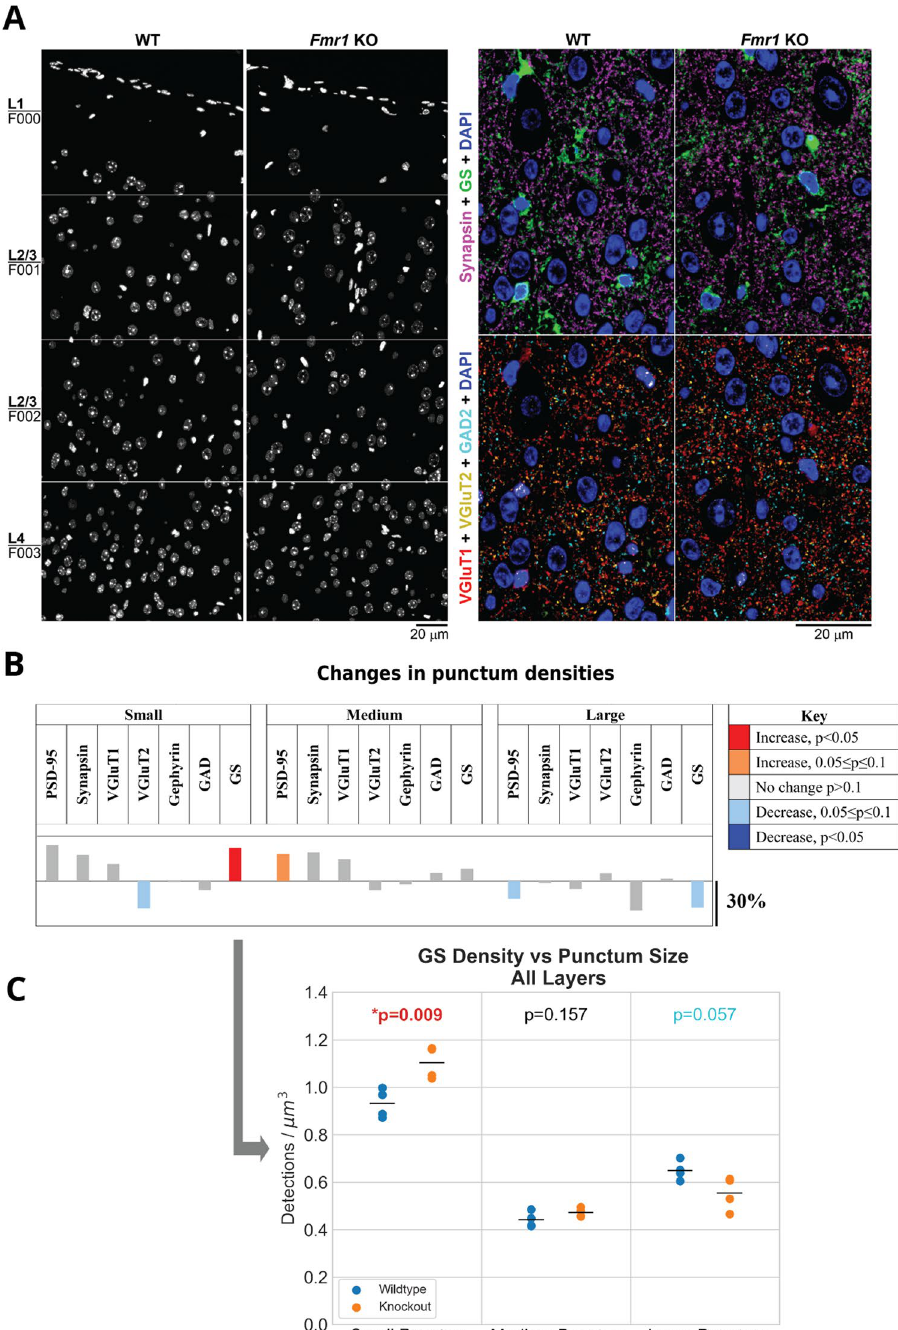
Figure 3. Overview of the datasets. ( A ) Immunofluorescent array tomography of wild-type and FMR1 knockout mouse somatosensory cortex. The left panel shows the imaged area in each sample, consisting of four tiles spanning cortical layers 1 through 4. DAPI staining of nuclei, volume reconstruction of 30 serial sections, 70 nm each. The right panel shows the immunofluorescence for synaptic (synapsin, VGluT1, VGluT2 and GAD2) and glial (GS) markers in wild-type and knockout mouse somatosensory cortex layer 4, volume reconstruction of 10 serial sections, 70 nm each. ( B ) Summary of single channel punctum density changes between wild-type and knockout mice with all layers averaged. The plots show the percentage difference between the wild-type and knockout mice and are color-coded to indicate direction of change and statistical significance. ( C ) This plot shows the density distribution of GS puncta by size. ‘Small’ puncta span one slice, ‘medium’ puncta span two slices, and ‘large’ puncta span three or more